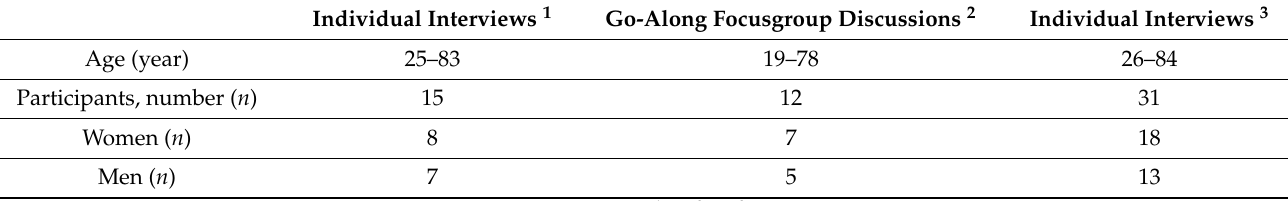
Table 1. Overview of previous data